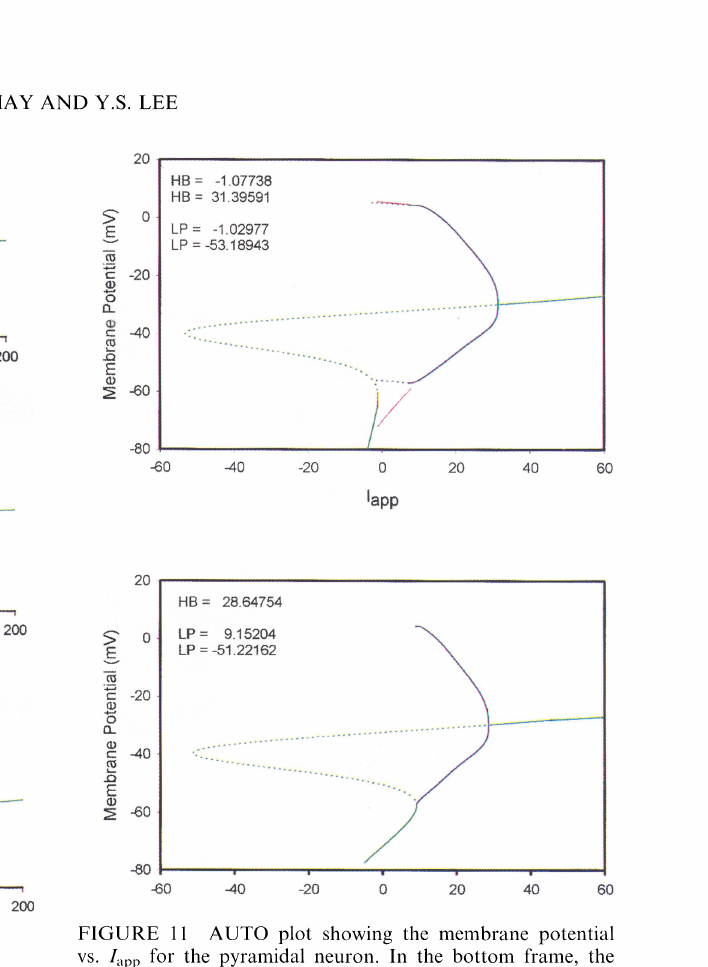
FIGURE l0 AUTO plot showing the membrane potential vs. I,vp for the thalamocortical neuron. The top frame was obtained using the five dynamic variables (d, jl h, n, and V), the middle frame was obtained using three dynamic variables (h, n, and V) by setting d and f at their steady state values, and the bottom frame was obtained by setting IN, 0. Here, the solid green lines are stable steady states and the dashed greens are unstable steady states. The blue envelope is a spik- ing branch (solid is stable and dashes are unstable). The pink circles on the top frame were obtained by solving the dynamic equations. In the top two frames, the limit points of the steady state occur at -167.9530 and 29.00959. In the top frame, the periodic limit points are located at 23.31332 and 170.04882, while in the middle frame these points are located at 27.5246 and 152.9140. HBs are listed in the figure. (See Color Plate II.)